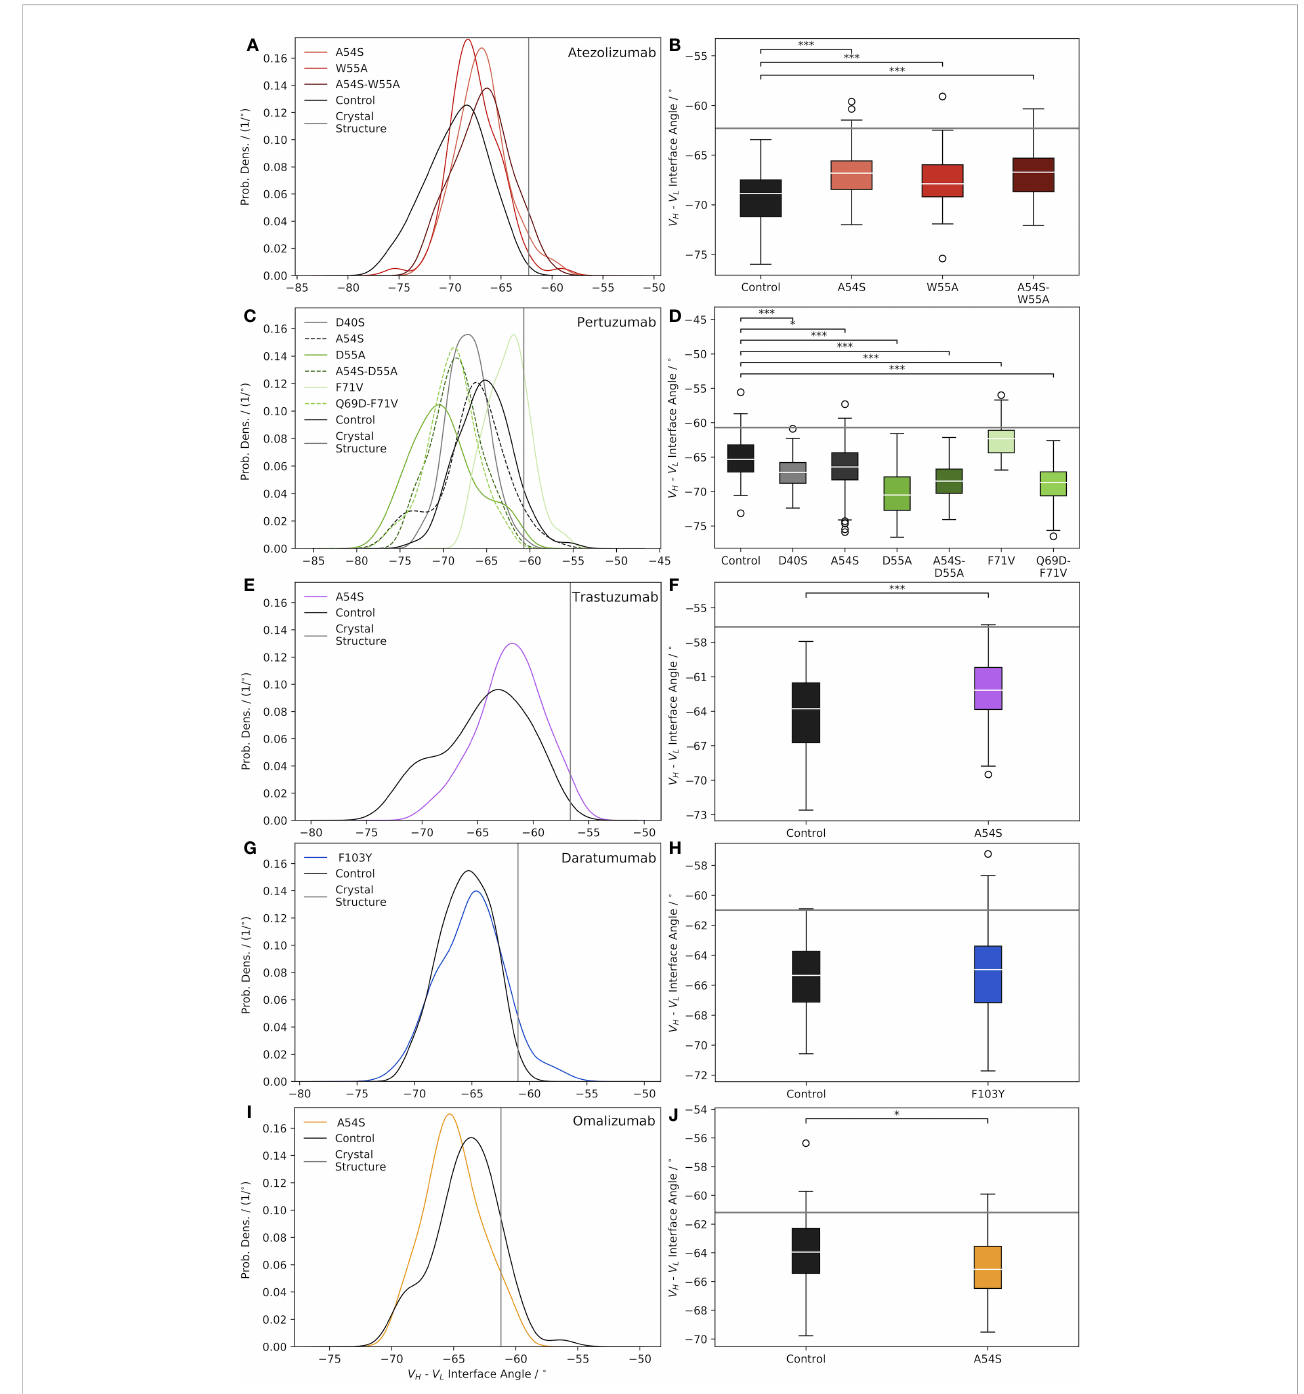
FIGURE 1 Characterization of Ab V H -V L interface angle distributions, shown as normalized probability densities (left plots) and boxplots (right plots), for: (A, B) Atezolizumab, (C, D) Pertuzumab, (E, F) Trastuzumab, (G, H) Daratumumab, and (I, J) Omalizumab. In each plot, a gray line indicates the Ab interface angle value for the respective crystal structure, and black curves/boxplots show the results for the mature ( “ Control ” ) Abs. Signi fi cance was assessed via a two-tailed t-test (*=p-value< 0.05; ***= p-value<